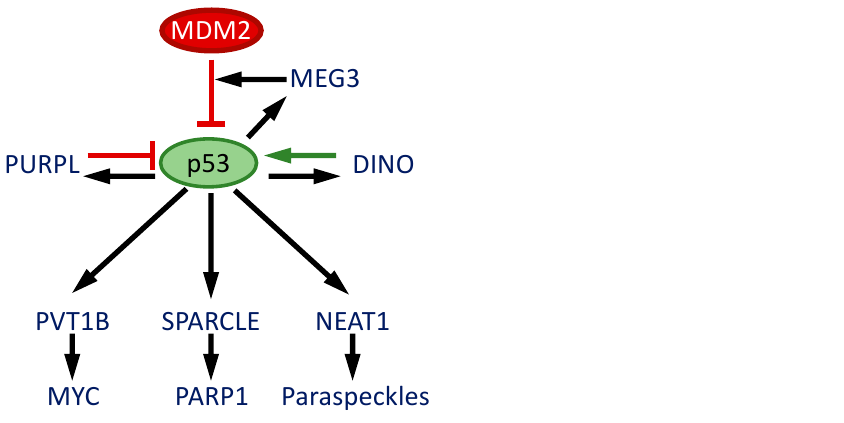
Figure 4. p53-related lncRNAs. p53 induces the expression of multiple lncRNAs that trigger a variety of cellular signaling circuits and biological responses. Some lncRNAs further induce and stabilize p53, while others restrict p53 levels. See text for details and references.